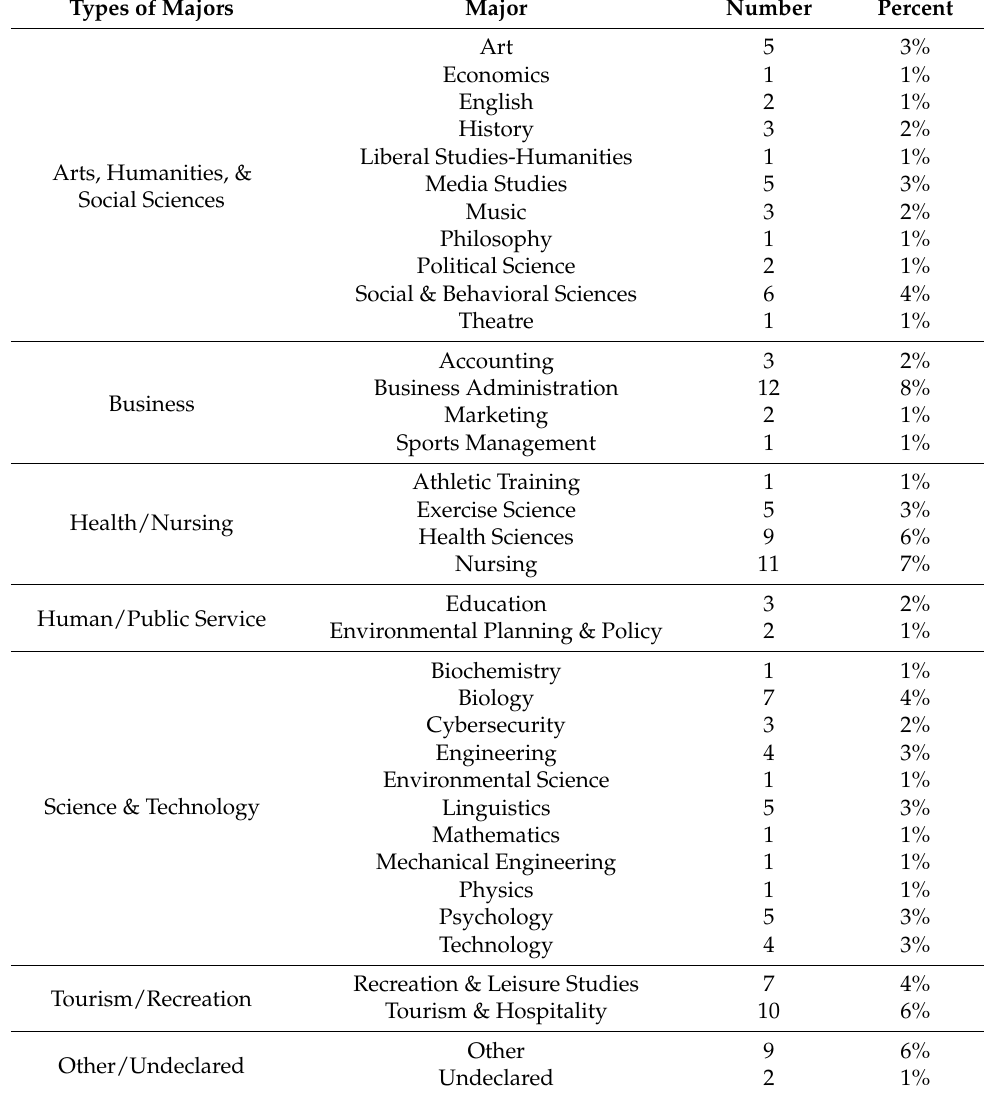
Table A1. Major and type of major (98% responding, n =